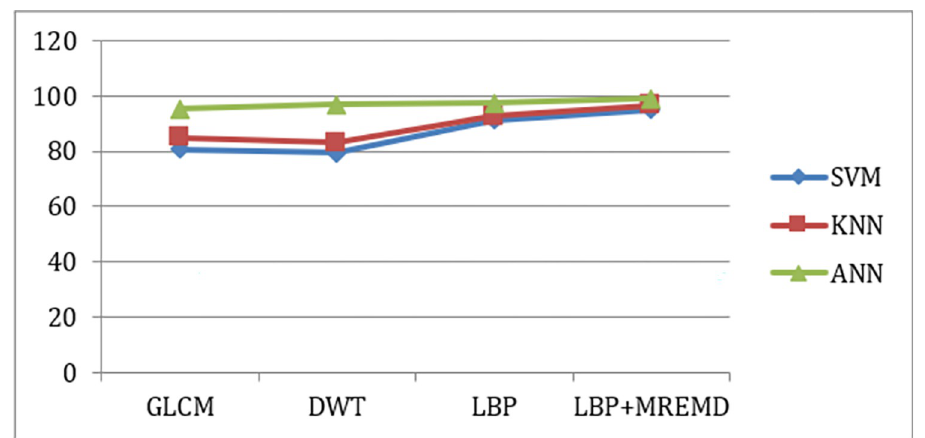
Fig 5. Performance comparison of different classifiers.